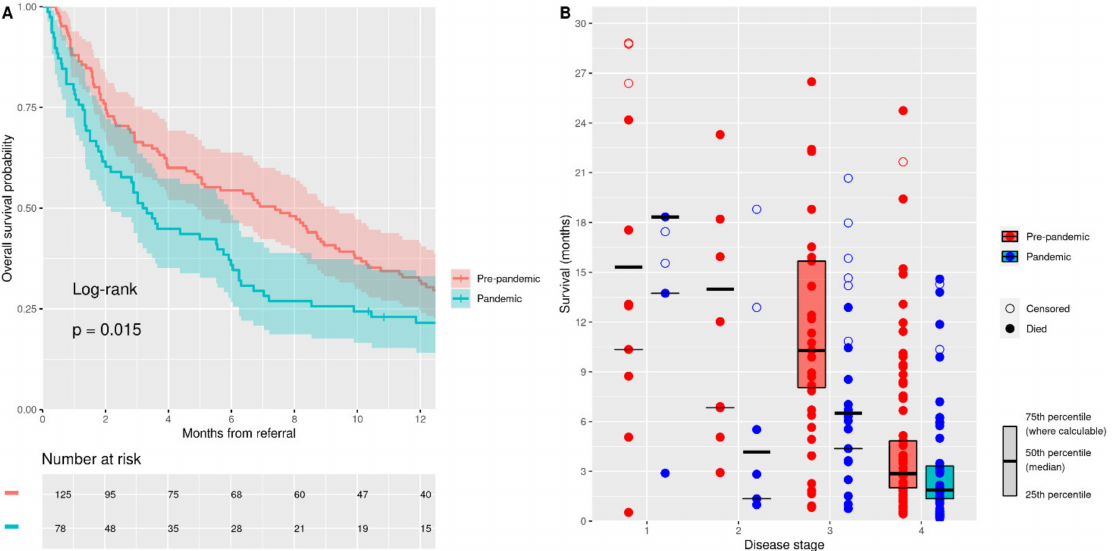
Figure 2. Survival analysis (all causes of mortality) from referral. ( A ) Kaplan–Meier plot of survival from referral (all disease stages at diagnosis). ( B ) Box plot of survival from referral in “pandemic” and “pre-pandemic” cohorts by disease stage at diagnosis. Individual cases plotted and IQR shown where the 75th percentile is calculable.